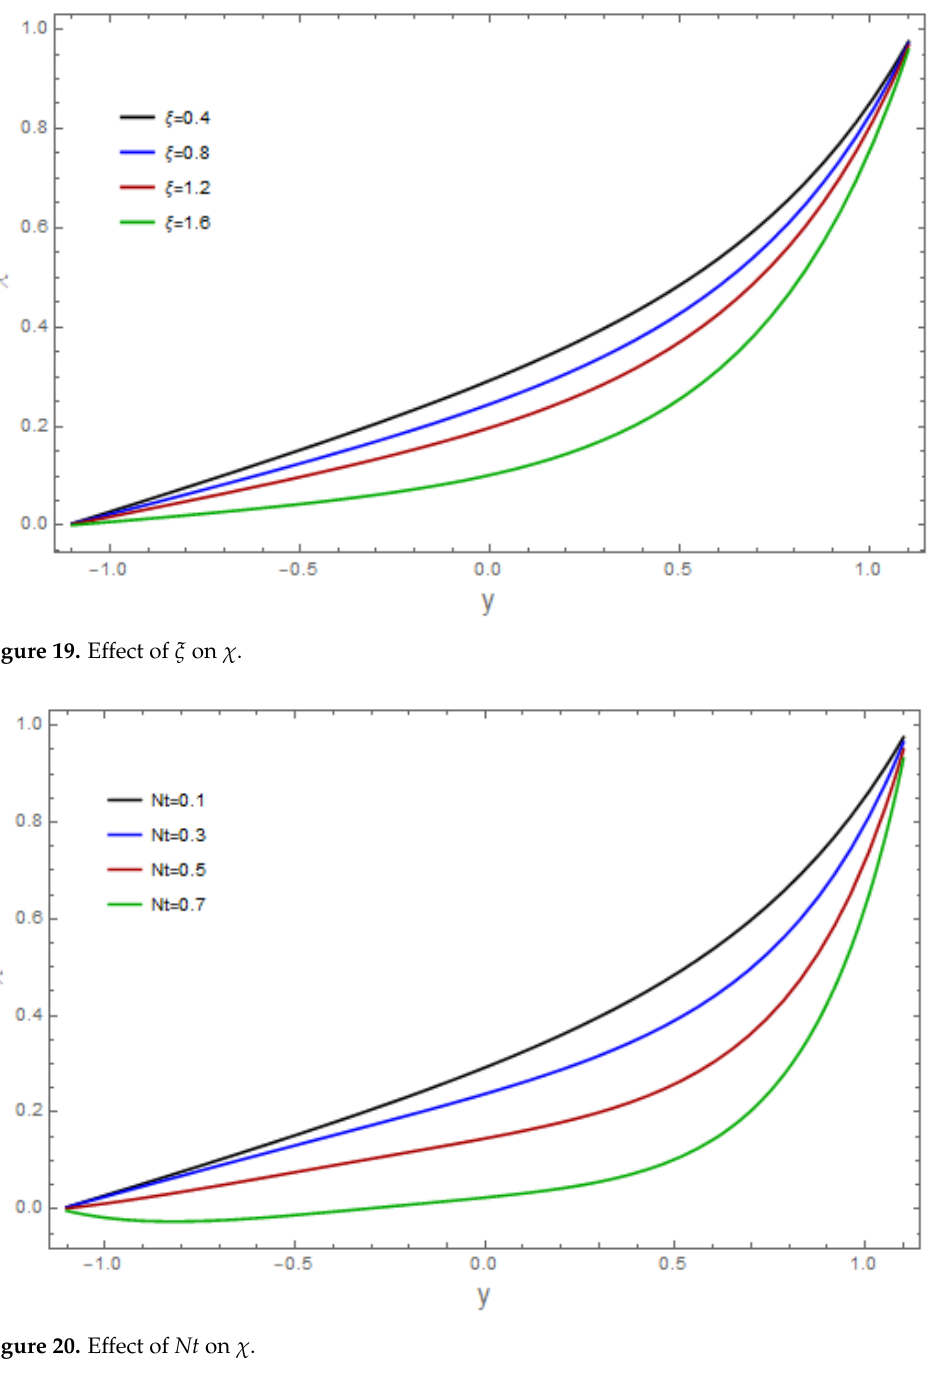
Figure 18. Effect of 𝑃𝑒 on 𝜒 .